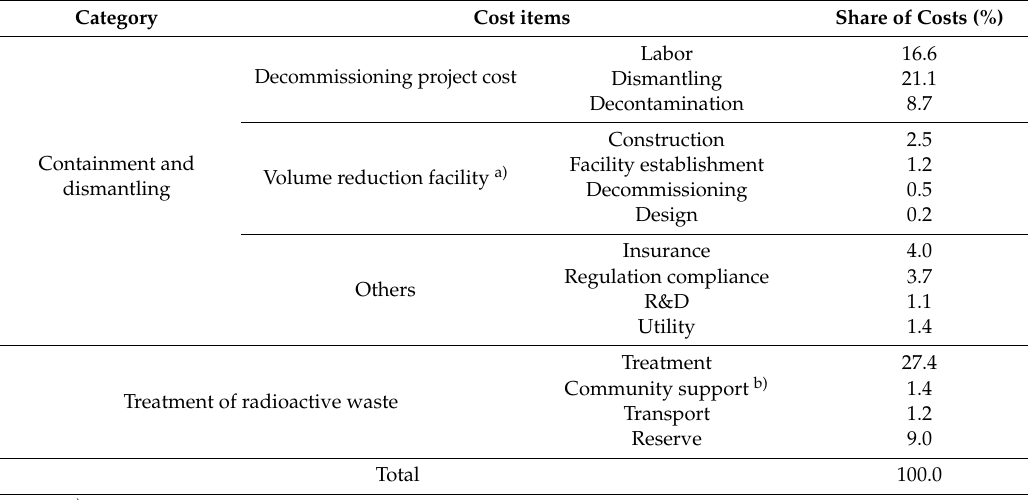
Table A1. The profile of nuclear decommissioning by task.